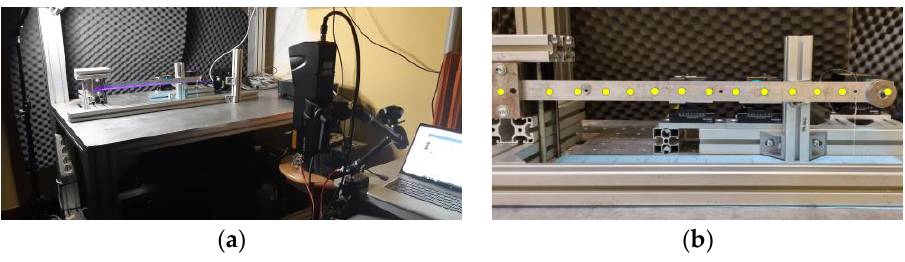
Figure 4. Laser beam generated by profilometer ( a ), and measured points ( b ).